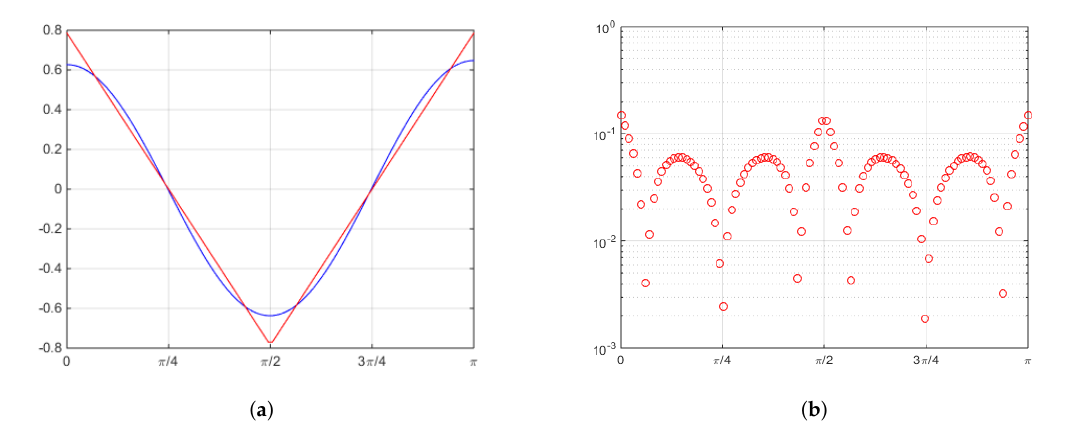
Figure 5. ( a ) Reconstructed potential (blue) and exact potential (red) p 1 ( x ) = | x − π /2 | − π /4 ( b ) Log absolute error in the reconstructed p 1